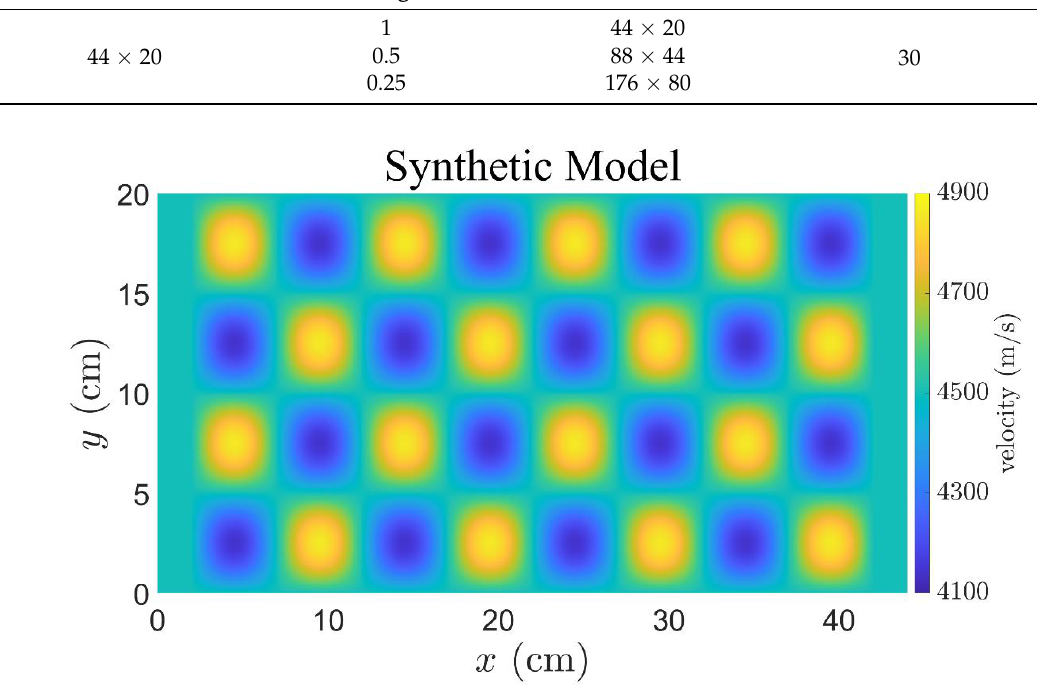
Figure 10. Tomographic results of checkerboard resolution tests with different grid lengths: ( a ) TDAT and ( b ) FAAT.